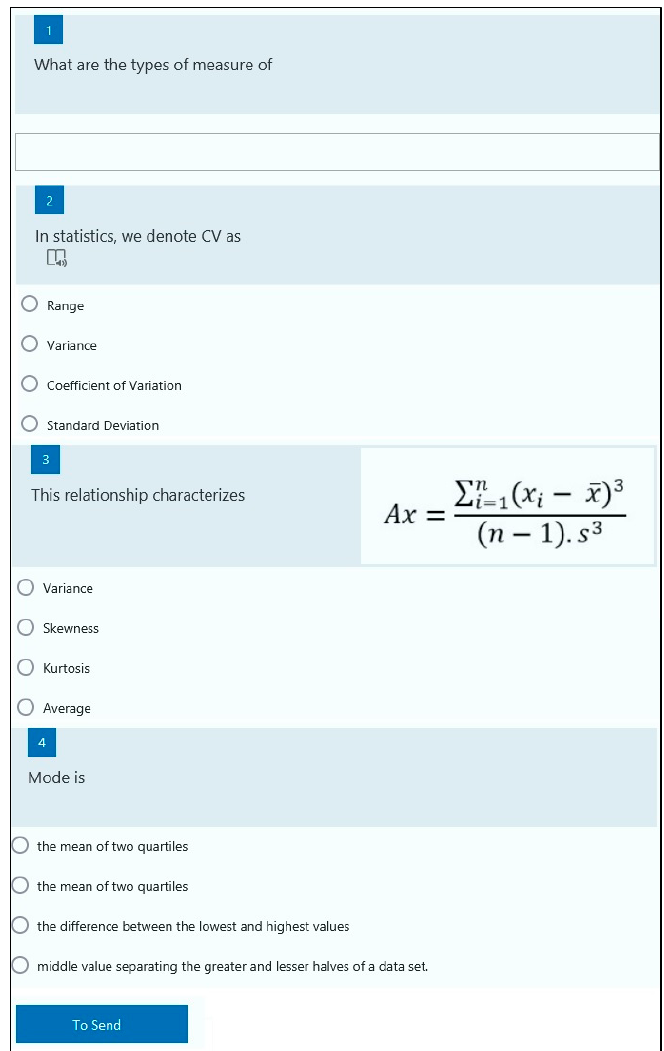
Figure 5. A sample of a test in Microsoft Forms.